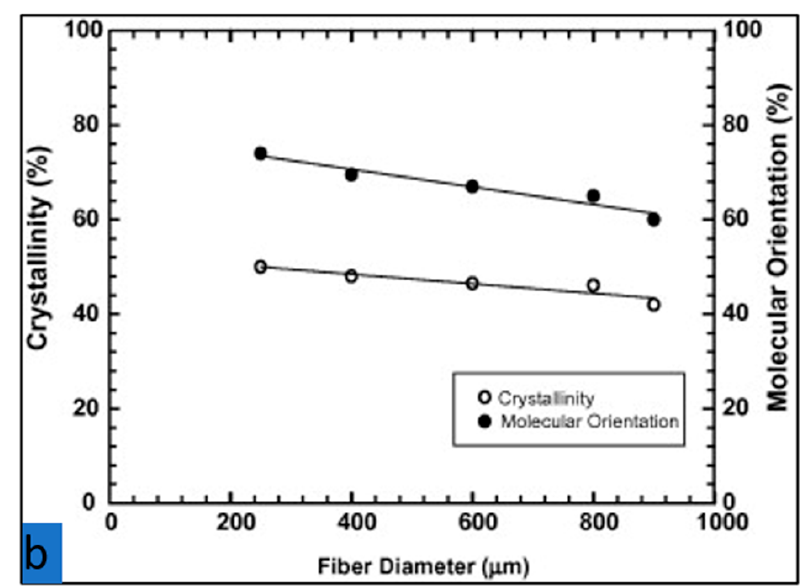
Figure 14. ( a ) Tensile strength/modulus vs fiber diameter [103]. ( b ) Crystallinity vs. fiber diameter [103].